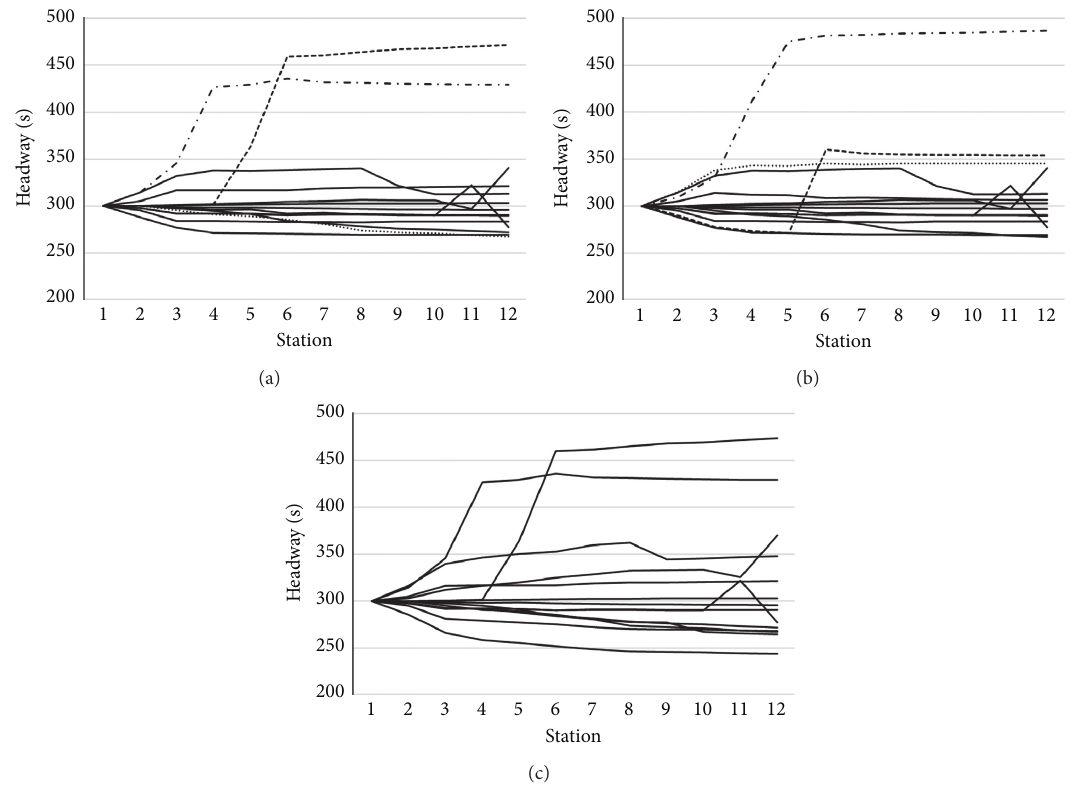
Figure 7: (a) Strategy A, (b) strategy B (dotted lines represent the headway of the full-length vehicles which adjoins the short-turn vehicles), and (c) strategy